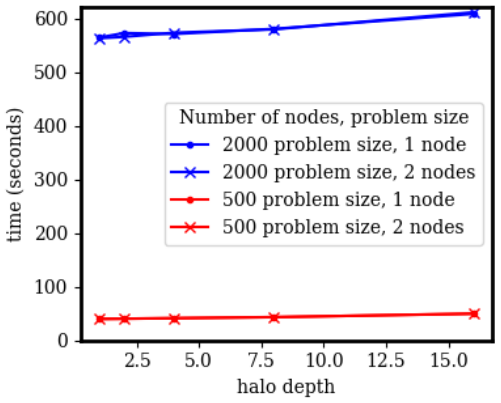
Figure 10. Effects of changing halo depth using a Cray machine.